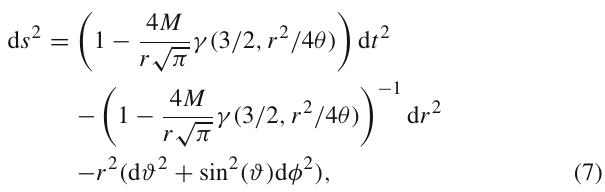
√ θ for various values of √ θ ( blue √ √ θ and M = 4 . 0 θ